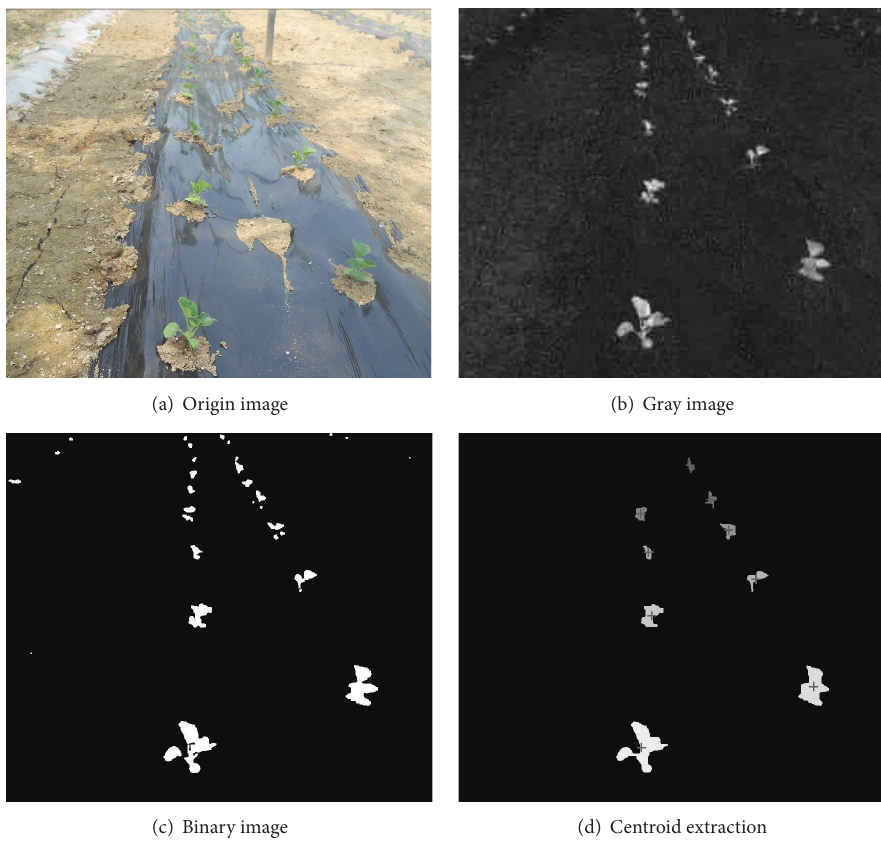
Figure 5: Image segmentation and feature